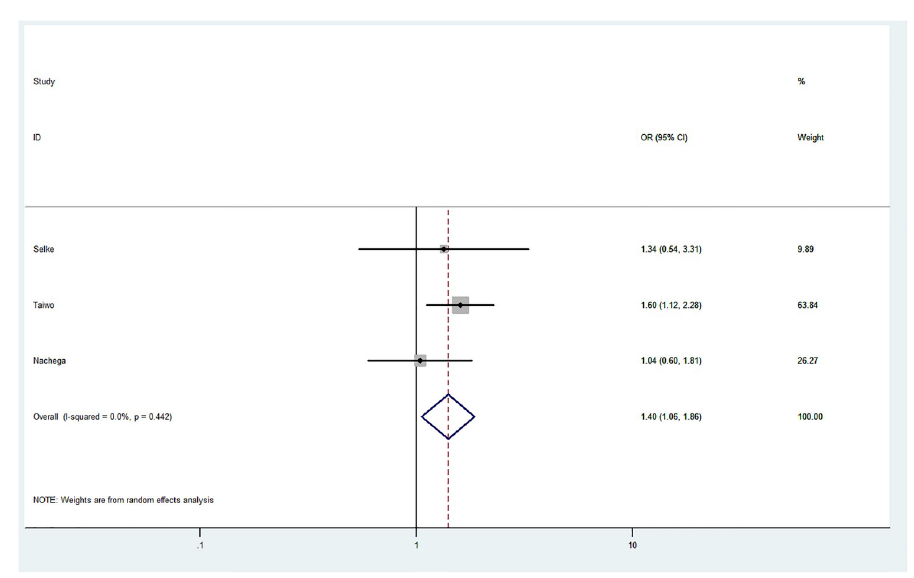
Fig 3. Pooled estimate for the impact of community health workers/lay workers on viral suppression. The circles represent the point estimate for viral suppression, the size of the grey squares around each point estimate reflect the weight of each study in the average effect size. The horizontal lines represent 95% confidence interval for the point estimate. The diamond represents the weighted average point